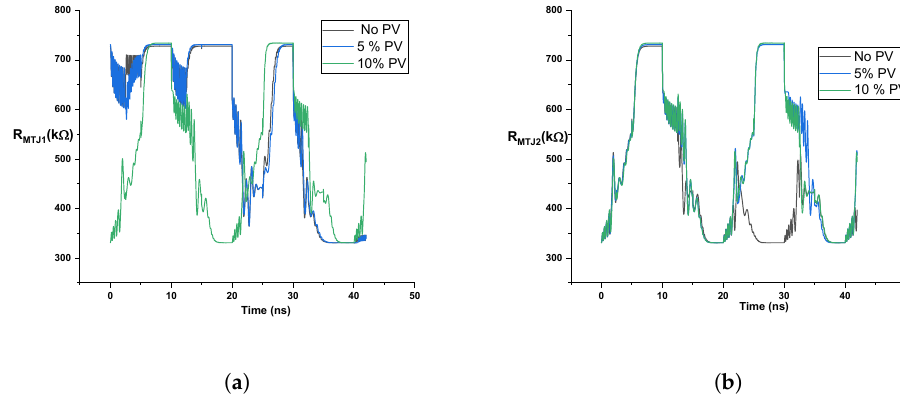
Figure 5. MTJ resistance variation for different PV % for ( a ) MTJ 1 and ( b ) MTJ 2